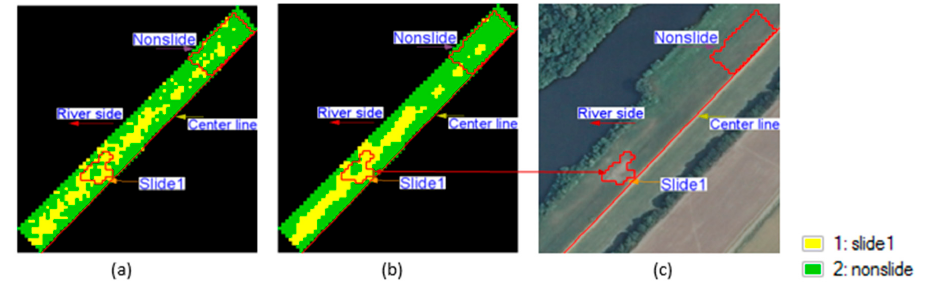
Figure 4. Magnitude data classification for the segment Sample 1: ( a ) without majority filter; ( b ) with majority filter; ( c ) optical image overlaid with slide and nonslide class shapes.